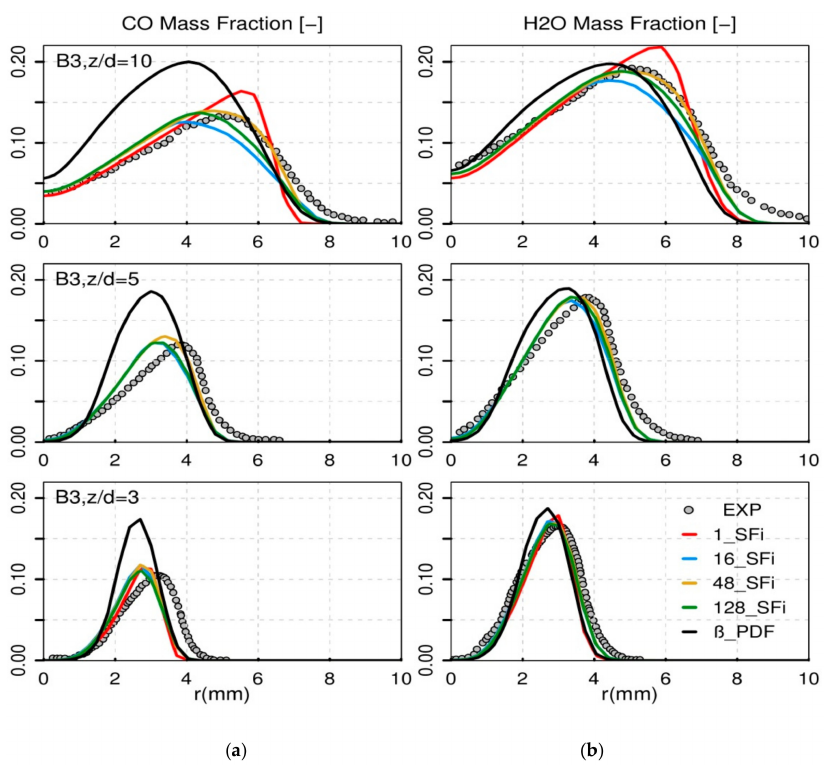
Figure 8. Mean CO ( a ) and H 2 O ( b ) mass fraction from ESF/FPV simulation for different SFi at different axial positions in comparison with Raman/Rayleigh data of B3 from